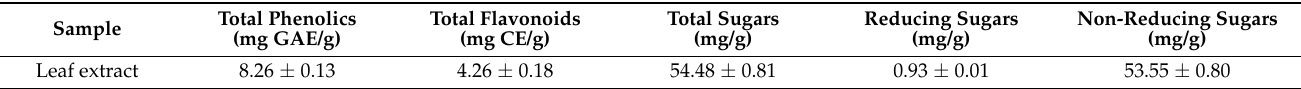
Table 1. Phytochemical analysis of Trigonella foenum-graecum L. (HM 425) aqueous leaf extract.